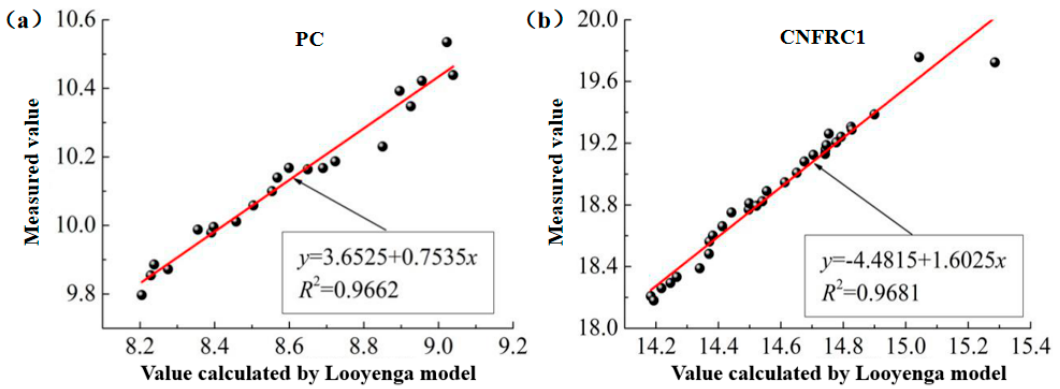
Figure 14. The fitting for relation between measured values and calculated values for ε , based on Looyenga model. ( a ) PC; ( b ) CNFRC1.